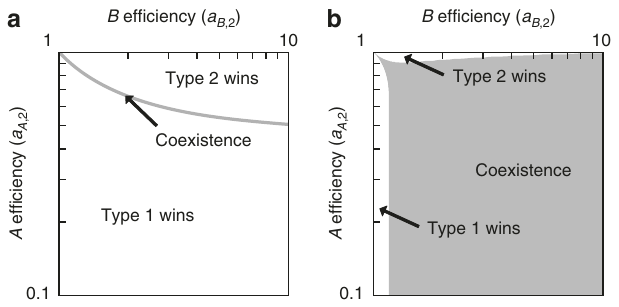
Fig. 1 Coexistence with and without diffusion. a The growth rate of a population consisting of a single cell type is a function of the maximum amount of each essential metabolite that it can produce, i.e., a A for A and a B for B . The gray line is the locus where the growth rate of a cell (type 2) equals that of a reference cell (type 1) that has equal costs for producing either metabolite, with a A ,1 = a B ,1 = 1. In the absence of diffusion, coexistence with the reference cell type is only possible where the growth rates are equal. Above the gray line, the type 2 cell grows faster and drives the type 1 cells to zero relative frequency, i.e., the type 2 cells “ win. ” Below the line, the situation is reversed. The coexistence line represents a transition between the different cell types winning. b With diffusion, e.g., when D = 3, each cell-type population is affected by the other ’ s production. The coexistence region is signi fi cantly larger and fi lls much of the quadrant considered, corresponding to where each cell type is more ef fi cient than the other at producing one of the